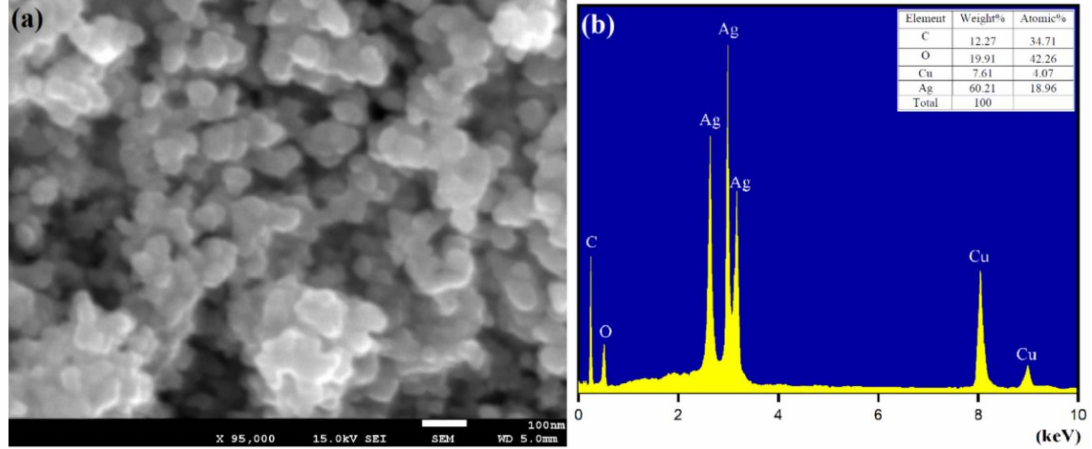
Figure 9. ( a ) SEM images and ( b ) EDX spectrum of biomolecule-capped